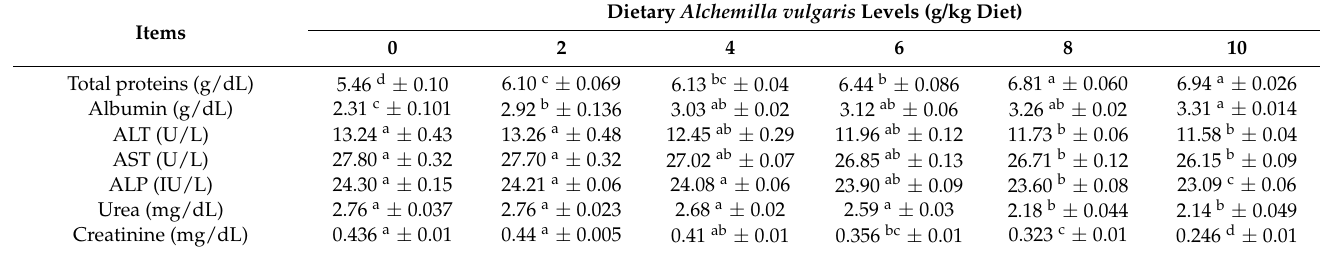
Table 4. Effect of Alchemilla vulgaris dietary supplementation on serum biochemical parameters of O. niloticus